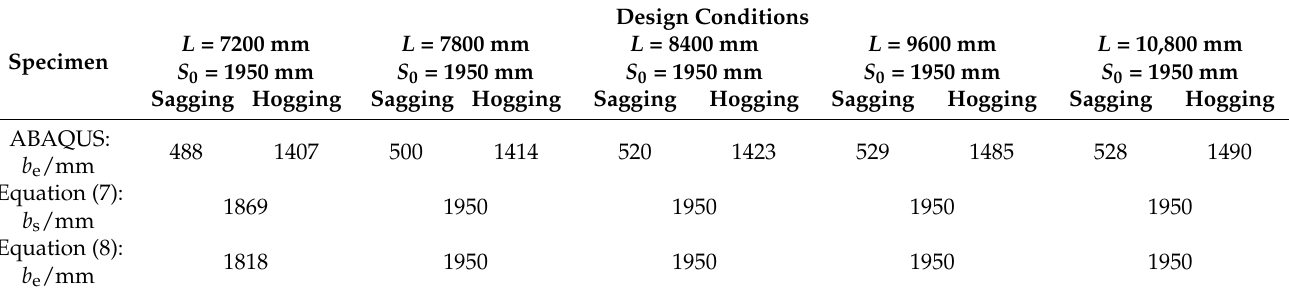
Table 4. The effective slab width under changing L.